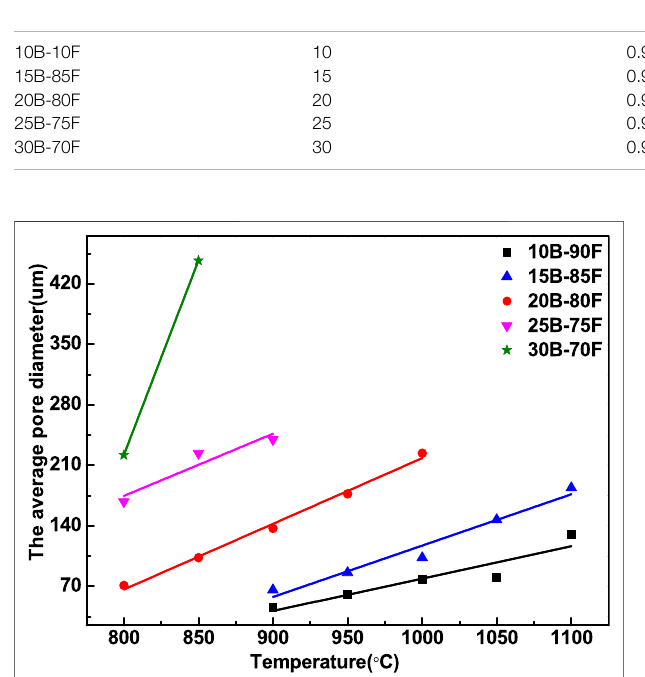
FIGURE 7 | Relationship between average pore diameter of porous galss-ceramics with different borax additions and temperature.